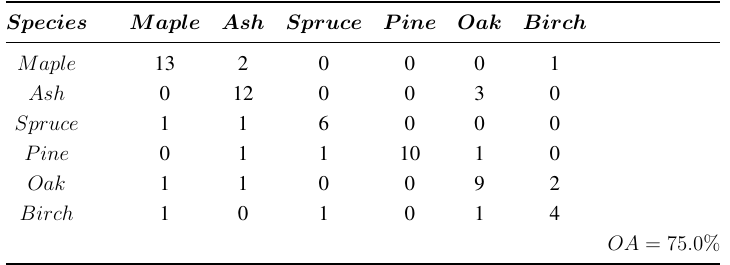
The C5.0 decision tree classification result with spectral, VI and Texture